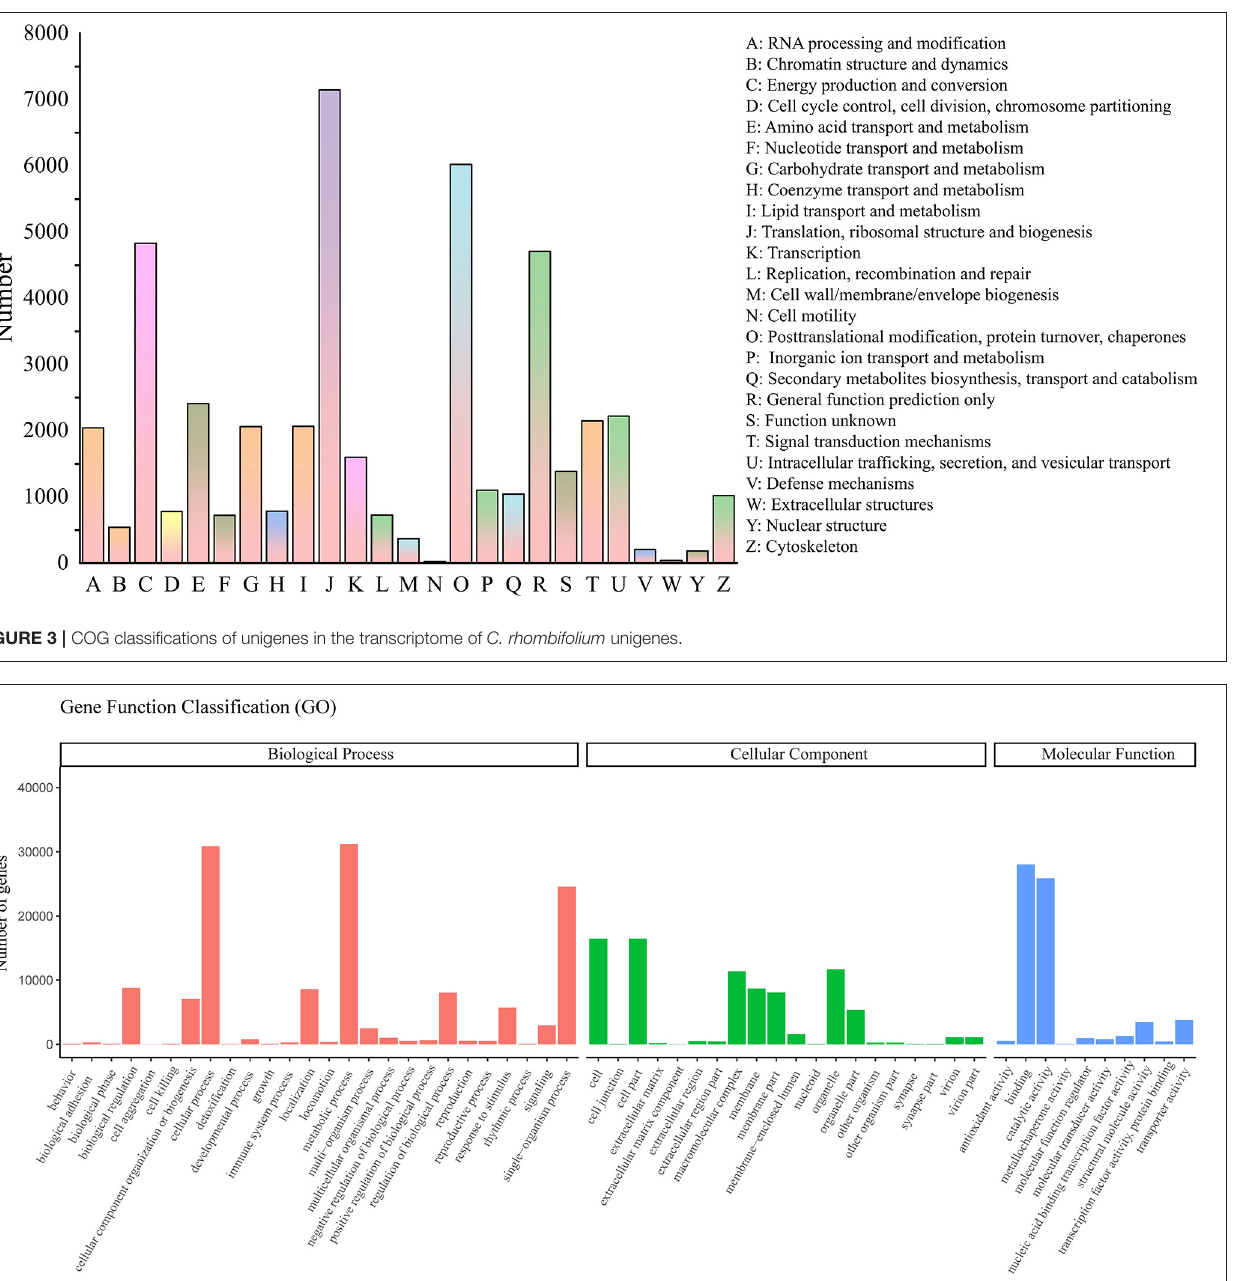
FIGURE 4 | Functional classification of C. rhombifolium unigenes based on Gene Ontology (GO) categorization. The results are summarized in three main GO categories: biological process (shown in red color), cellular component (shown in green color) and molecular function (shown in blue color). The x-axis indicates the subcategories, and the y-axis indicates the numbers related to the total number of GO terms present.